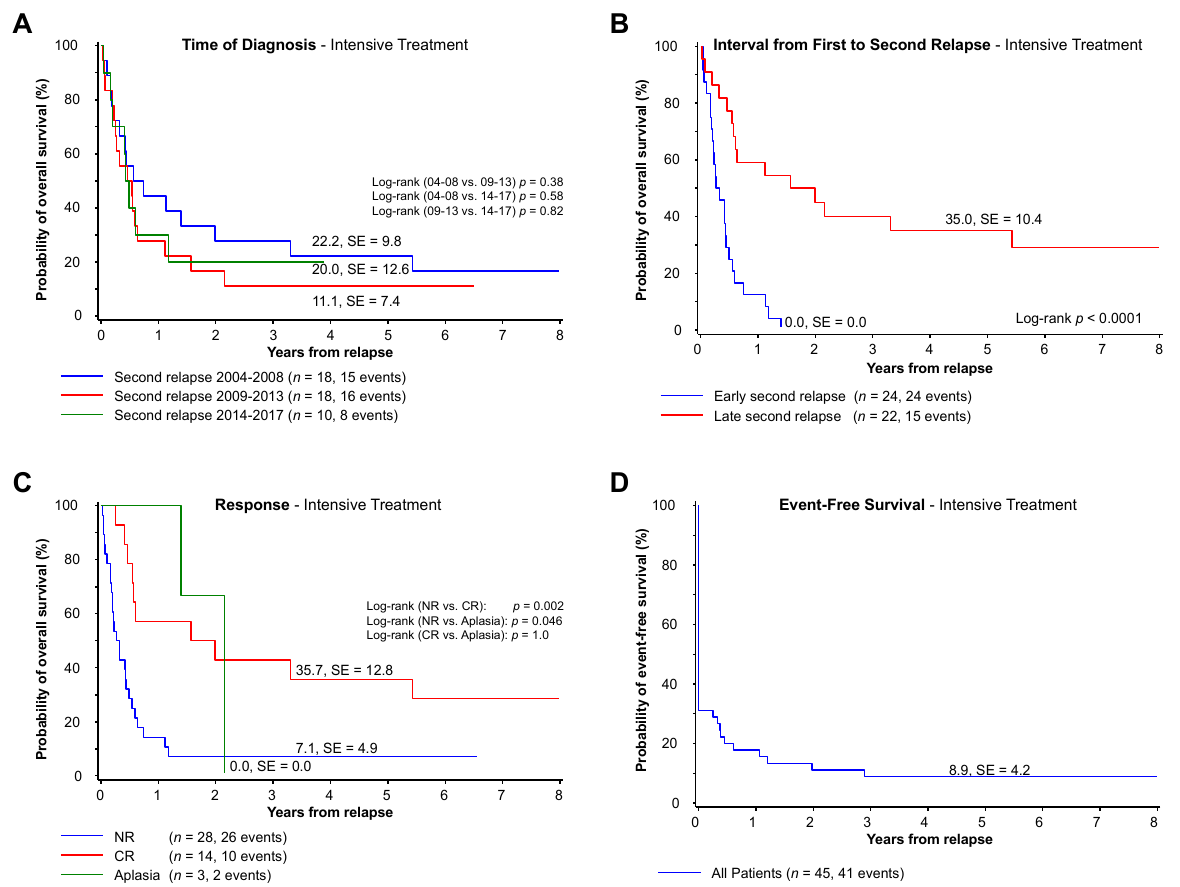
Figure 4. Patients receiving intensive treatment. ( A ) Five-year overall survival in patients with diagnosed second relapse of AML from 2004 until 2017 and treated with intensive treatment grouped by time of diagnosis. ( B ) Five-year overall survival of patients with intensive treatment with early or late second relapse defined as relapse within or after one year after first relapse. ( C ) Five-year overall survival of patients treated with intensive treatment based on the response status after up to two cycles of treatment. ( D ) Five-year event-free survival of patients treated with intensive treatment. Abbreviations: HSCT, hematopoietic stem cell transplantation; NR, nonresponse; CR, complete remission; Aplasia, no evidence of blasts, but missing peripheral regeneration.